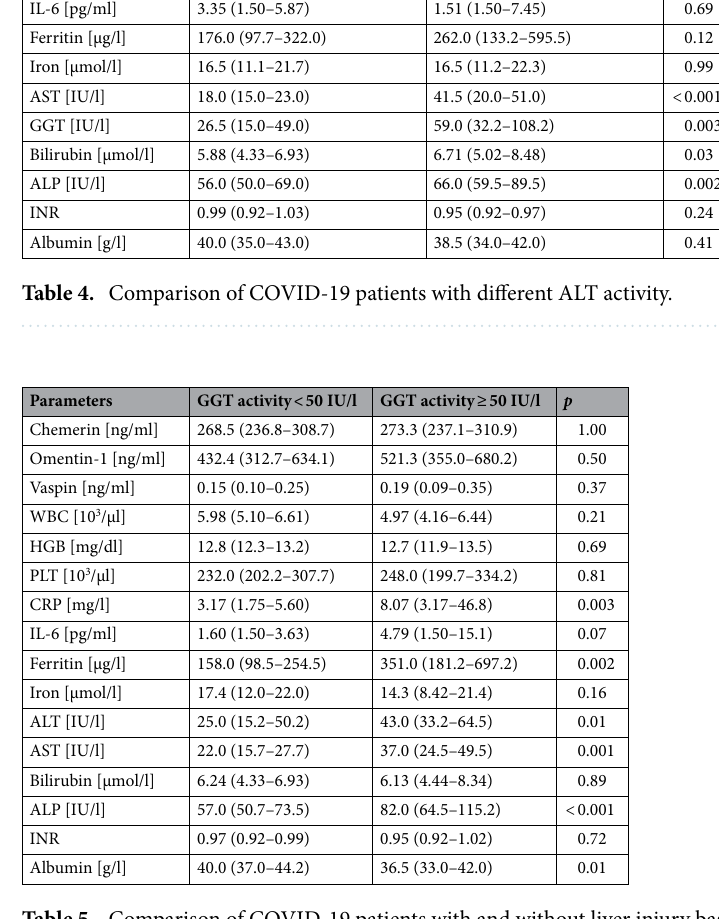
Table 5. Comparison of COVID-19 patients with and without liver injury based on GGT activity.